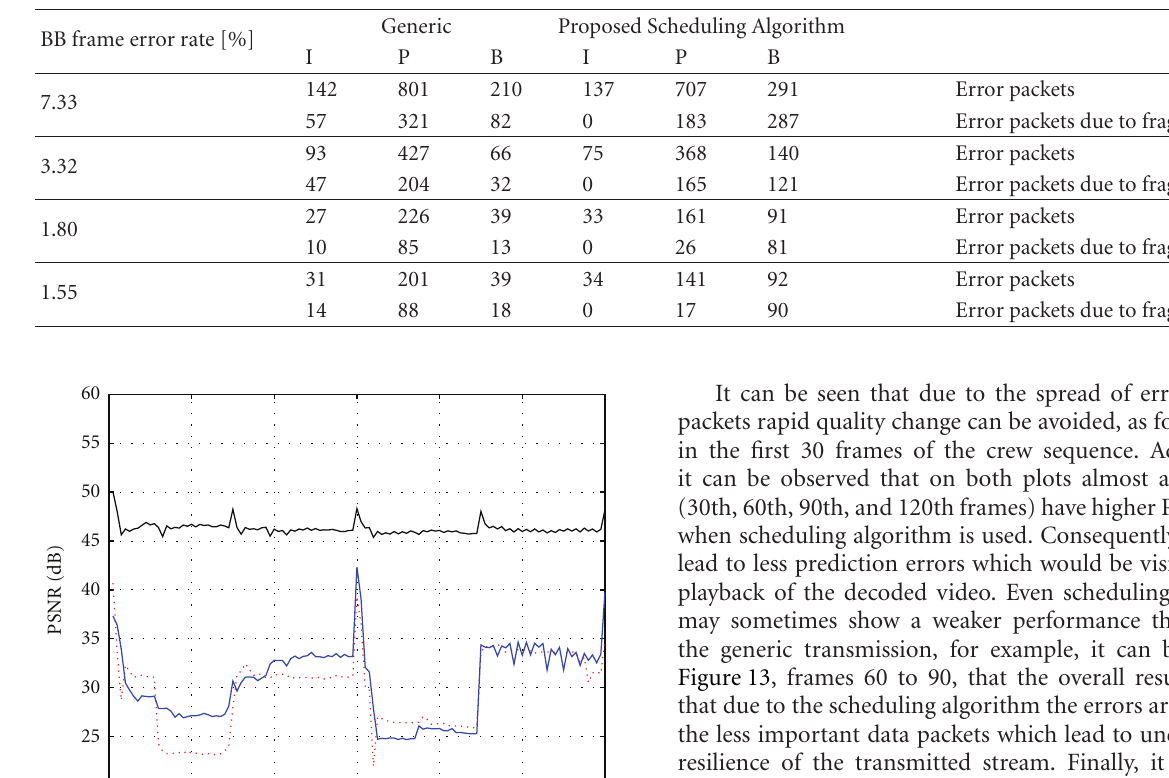
Table 8: Number of erroneous packets (crowd).